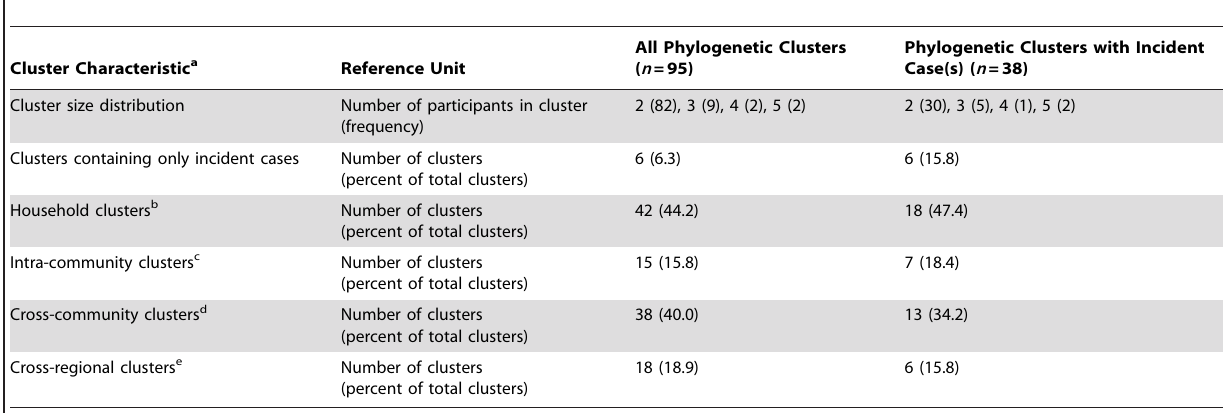
Table 2. Characteristics of 95 phylogenetic clusters identified in maximum likelihood phylogenetic analyses (HKY-85) of 915 gag sequences and 1,026 env sequences obtained from 1,099 HIV-infected participants in RCCS R13.